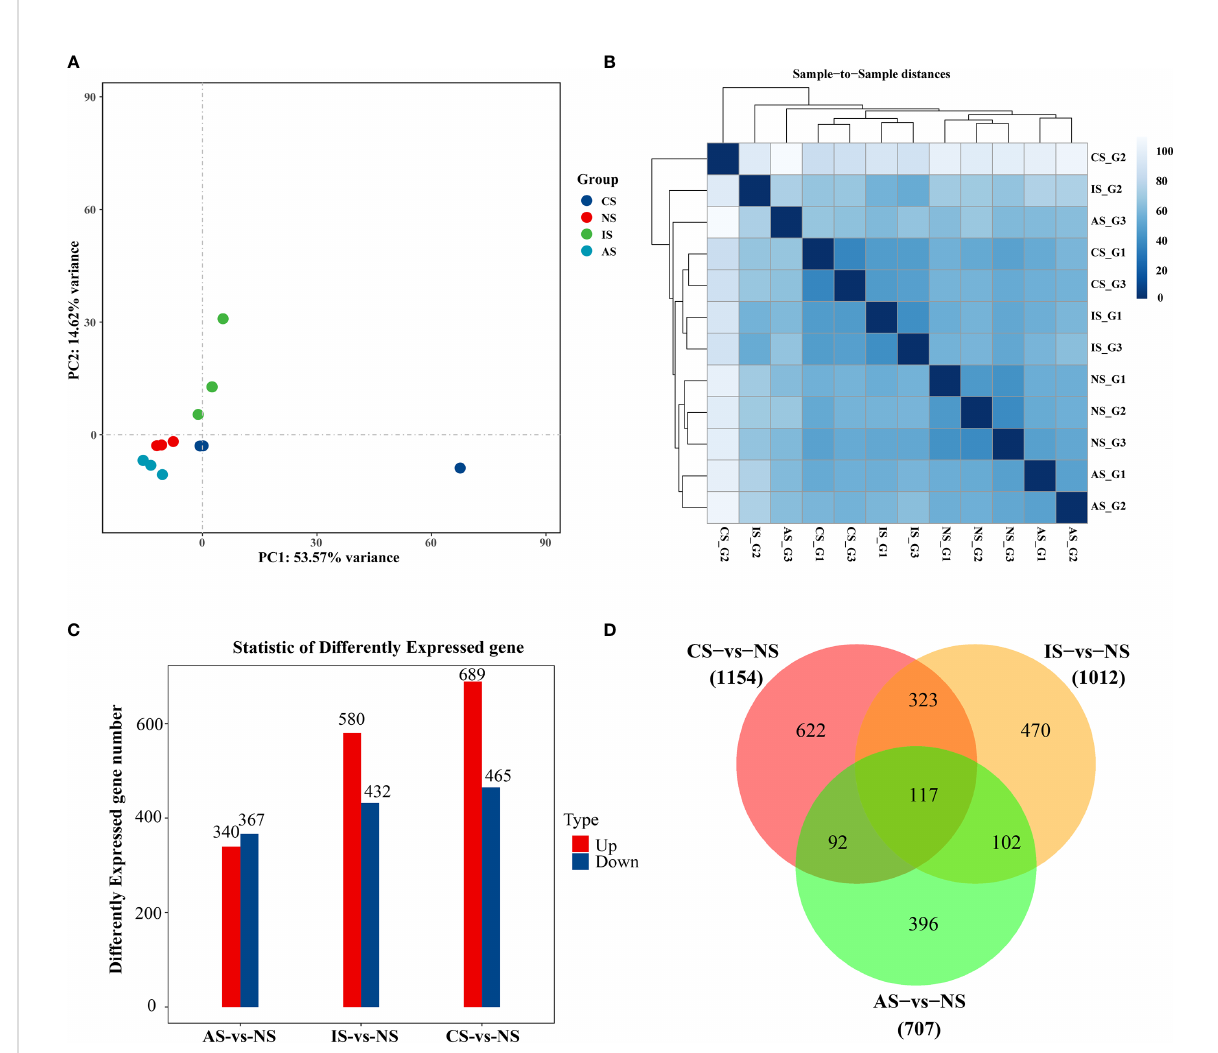
FIGURE 1 Differential gene expression analysis. (A) PCA diagram. (B) Cluster analysis results. (C) Bar Chart. (D) VennGraph. In (A) , dots represent samples, colors represent groups. In (B) , the horizontal axis represents the sample name, the vertical axis represents the corresponding sample name, and the color represents the size of the correlation coef fi cient. Foldchange> = 2.00 and adjusted p-value <=